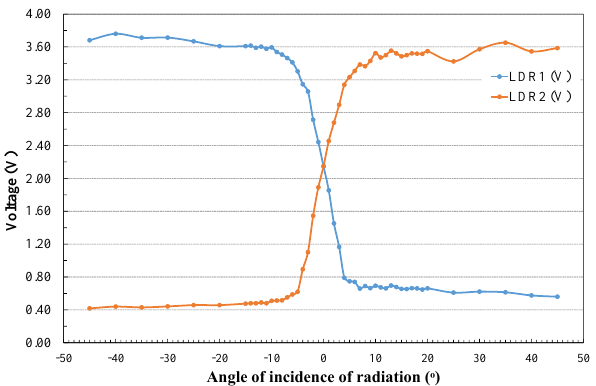
Figure 13. Variation of LDRs voltage as a function of the angle of incidence of light radiation.